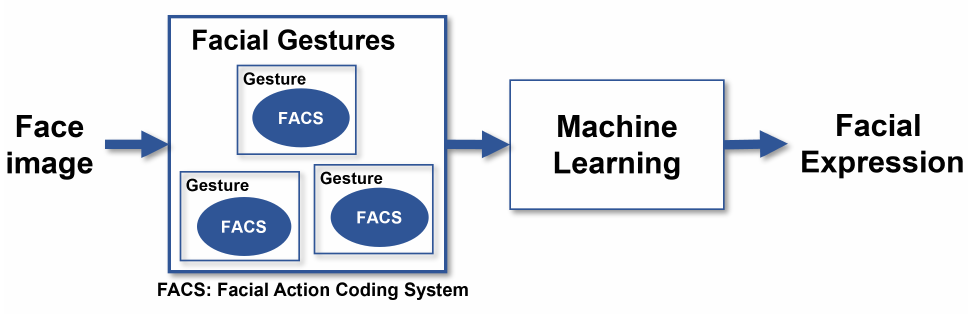
Figure 1. A common facial expression recognition system based on the analysis of face images and machine-learning algorithms to output a facial